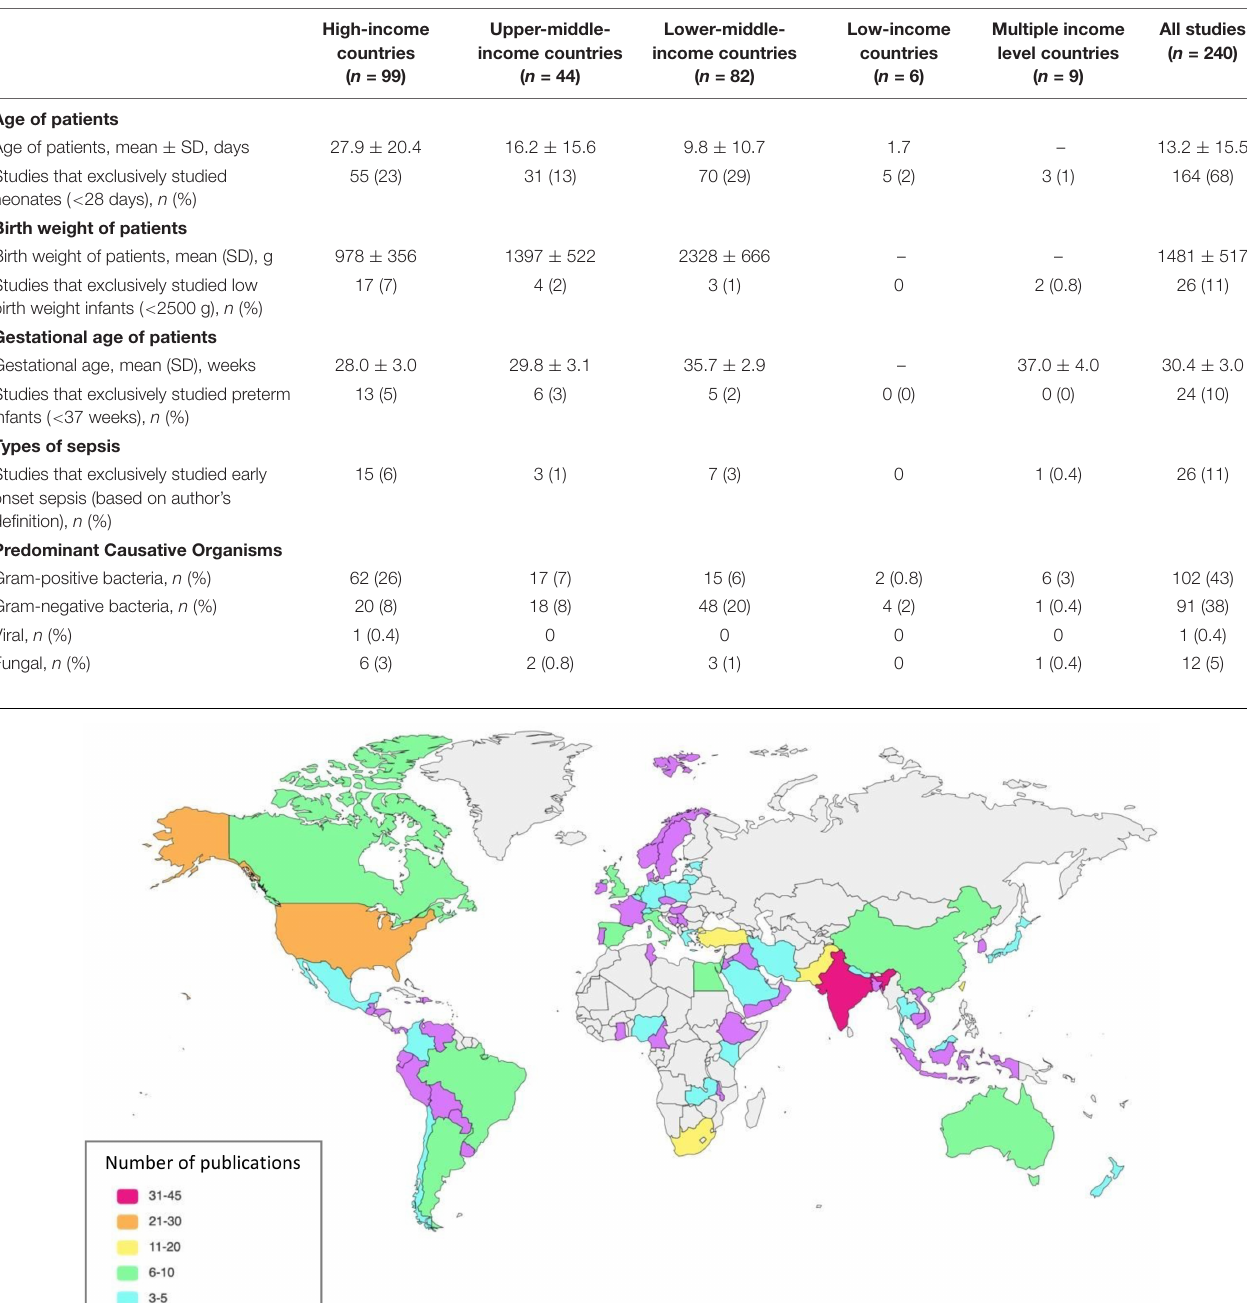
TABLE 2 | Characteristics of study population.